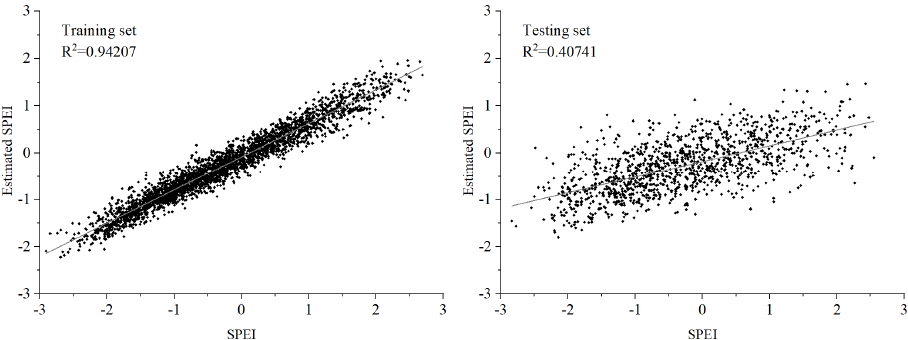
Figure 3. Correlation analysis between estimated and measured SPEI